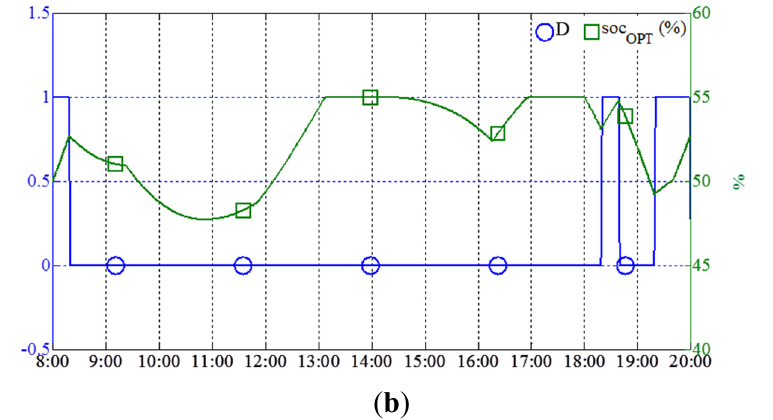
Figure 8. ( a ) Predicted and optimized power flow for Test 1; ( b ) D and soc evolution given by optimization for Test 1.